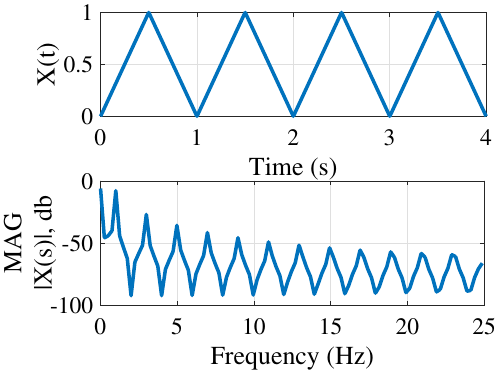
Figure 9. A triangular signal was used to apply horizontal entrance movement along the X axis of the world frame, resulting in rich frequency components.